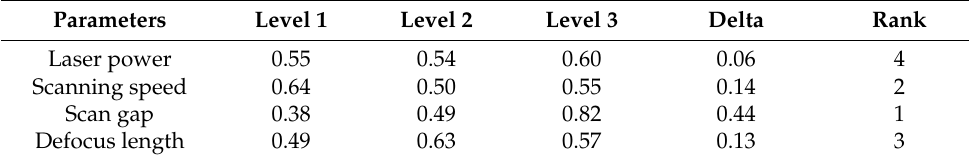
Table 7. Response table of average